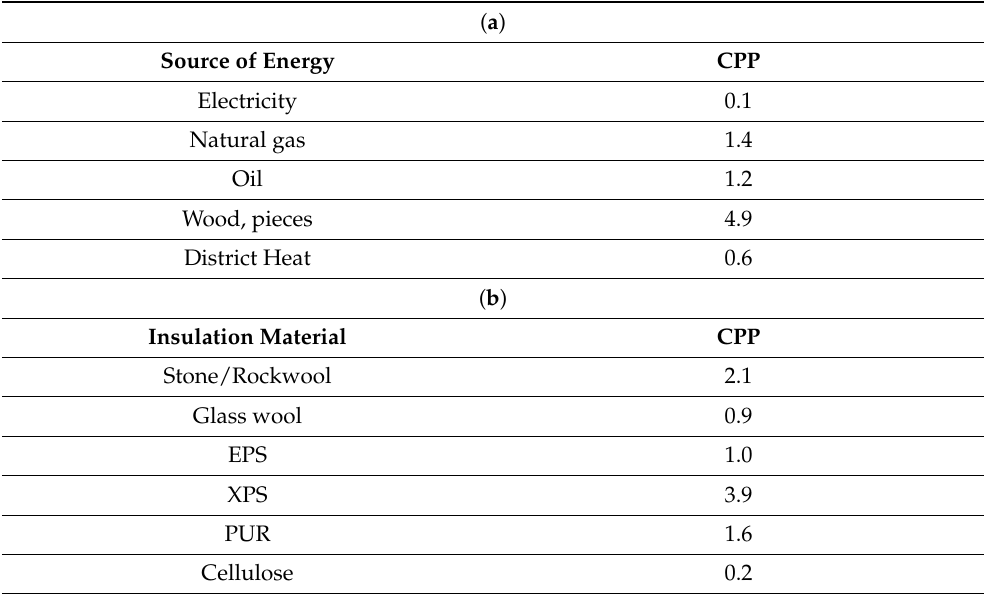
Table 8. ( a ) Average CPP values for different energy sources. ( b ) Average CPP values for various insulation materials.